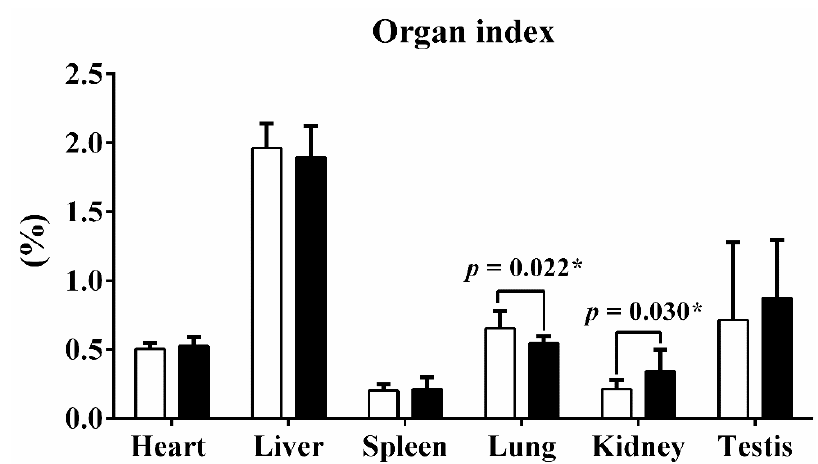
Figure 1. The organ index of six tissues between two different lines. The organ index quantified the ratio of organ weight to total body weight. Values are shown as mean ± SD ( n = 10 individuals per group). * represents p < 0.05.